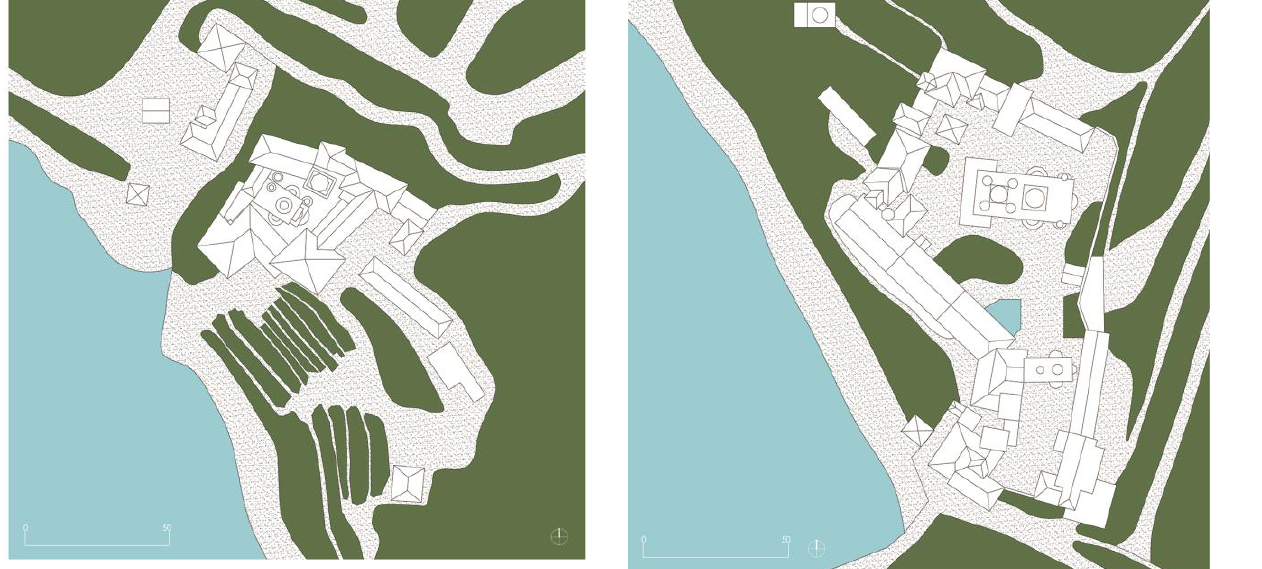
Figure 12 . The Monastery of Xenophontos. General